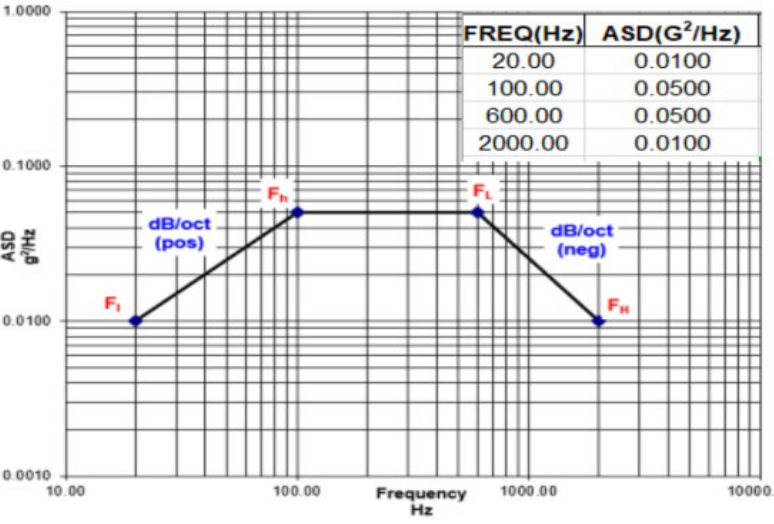
Figure 18. ASD vs. frequency curve (log-log).